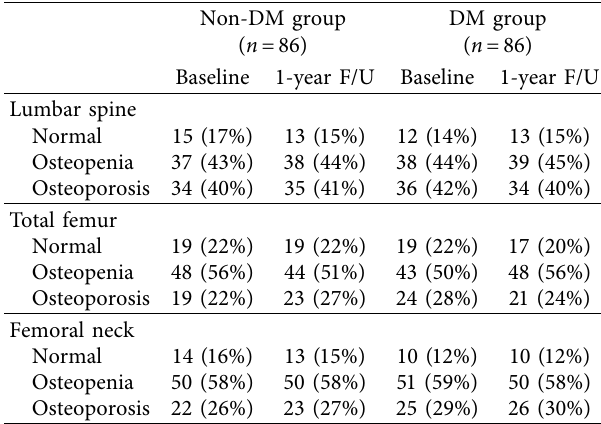
Table 3: Prevalence of osteoporosis and osteopenia in postmen- opausal women receiving lumbar epidural injections.